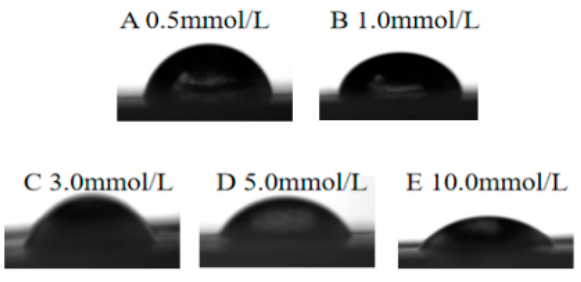
Figure 6. Droplet shape of C 10 DDGPB with different concentrations on a polytetrafluoroethylene (PTFE) membrane after 100 s.